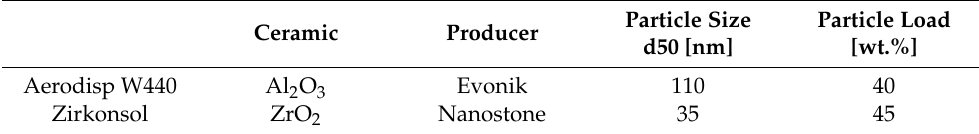
Table 1. Commercially available ceramic components used for alumina toughened zirconia. (d 50 is the mass median diameter which is the portions of particles with diameters smaller and larger than this value are